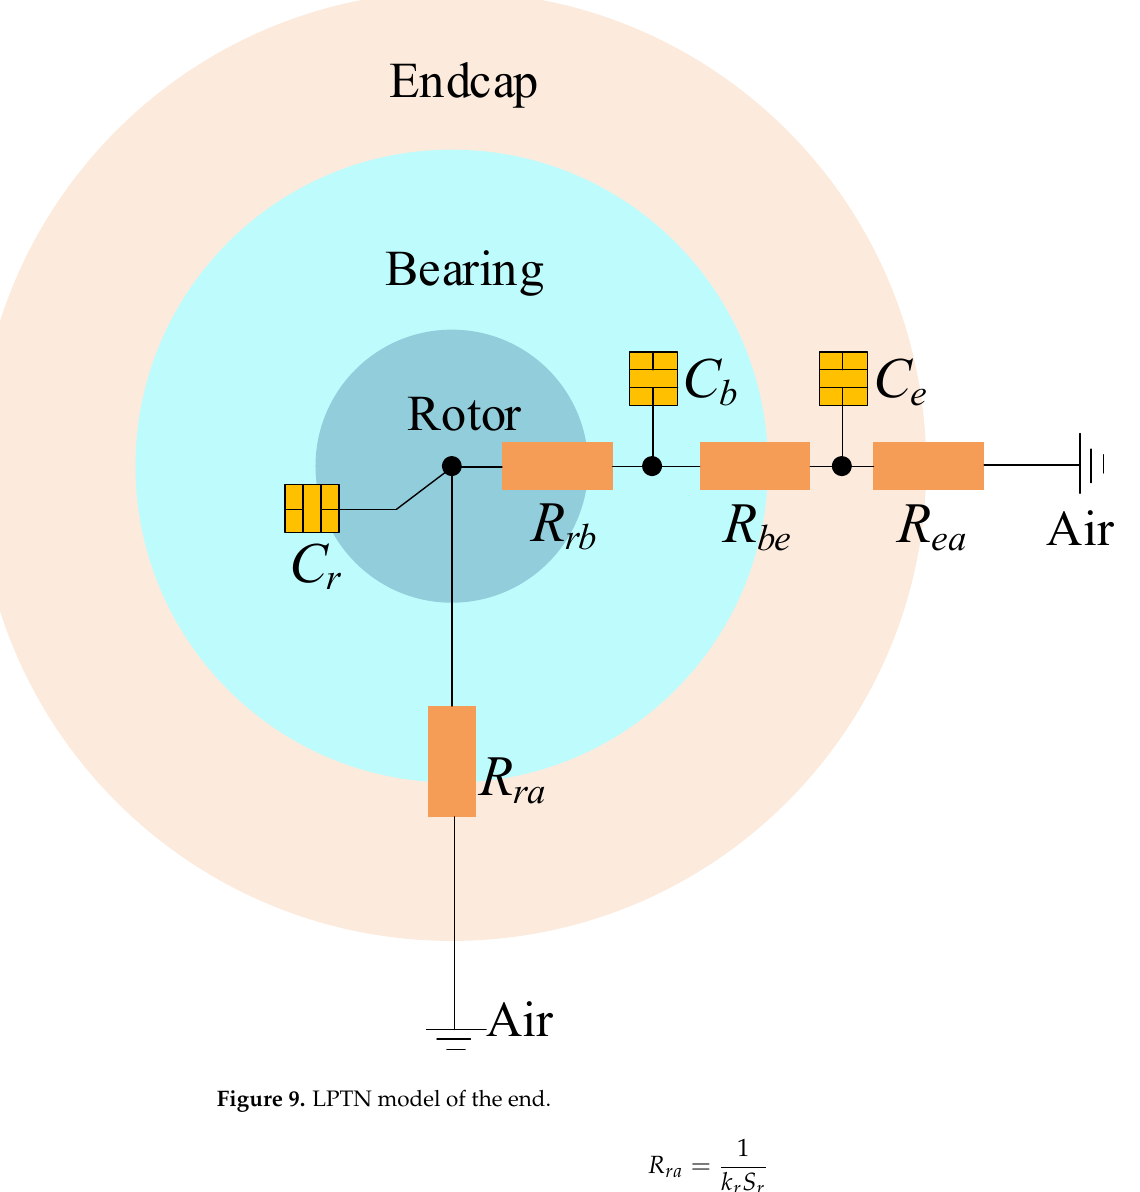
Figure 9. LPTN model of the end.